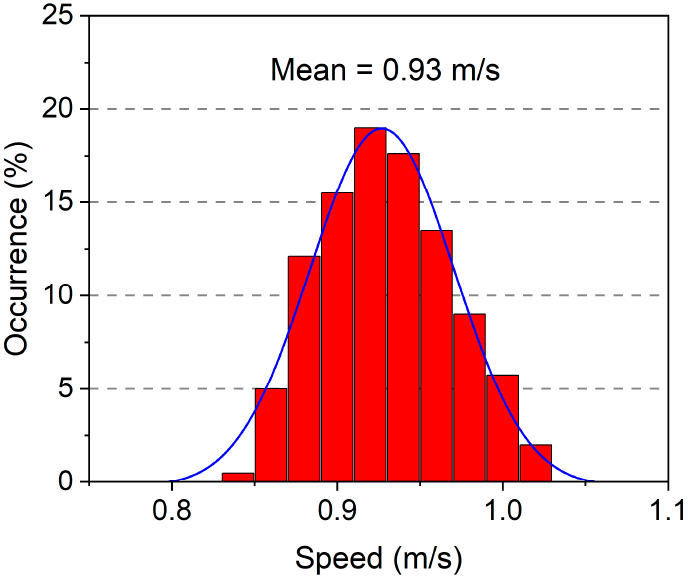
Figure 8. Statistics distribution for velocities.